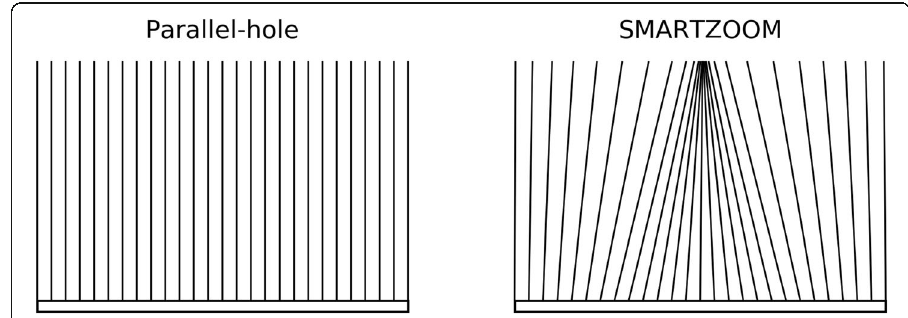
Fig. 1 An illustration of the field of view of a conventional parallel-hole collimator and the SMARTZOOM collimator. The highest sensitivity is achieved in the regions with the highest line